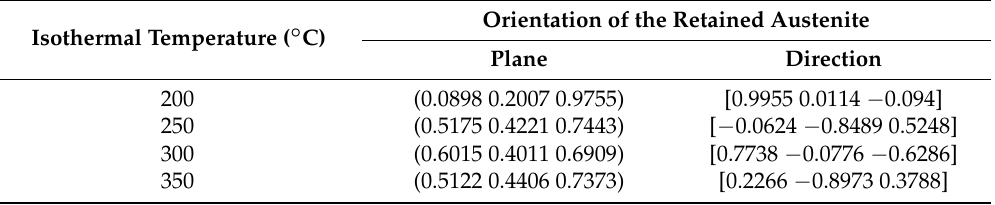
Table 2. The orientation of the retained austenite of the selected area at different temperatures.